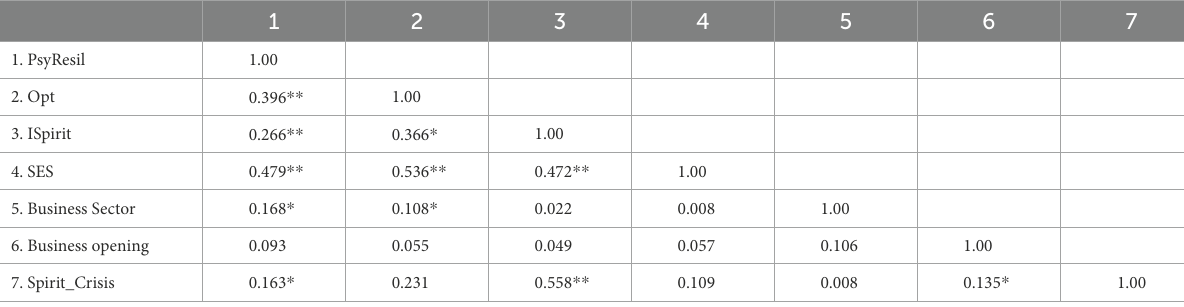
TABLE 2 Correlations.